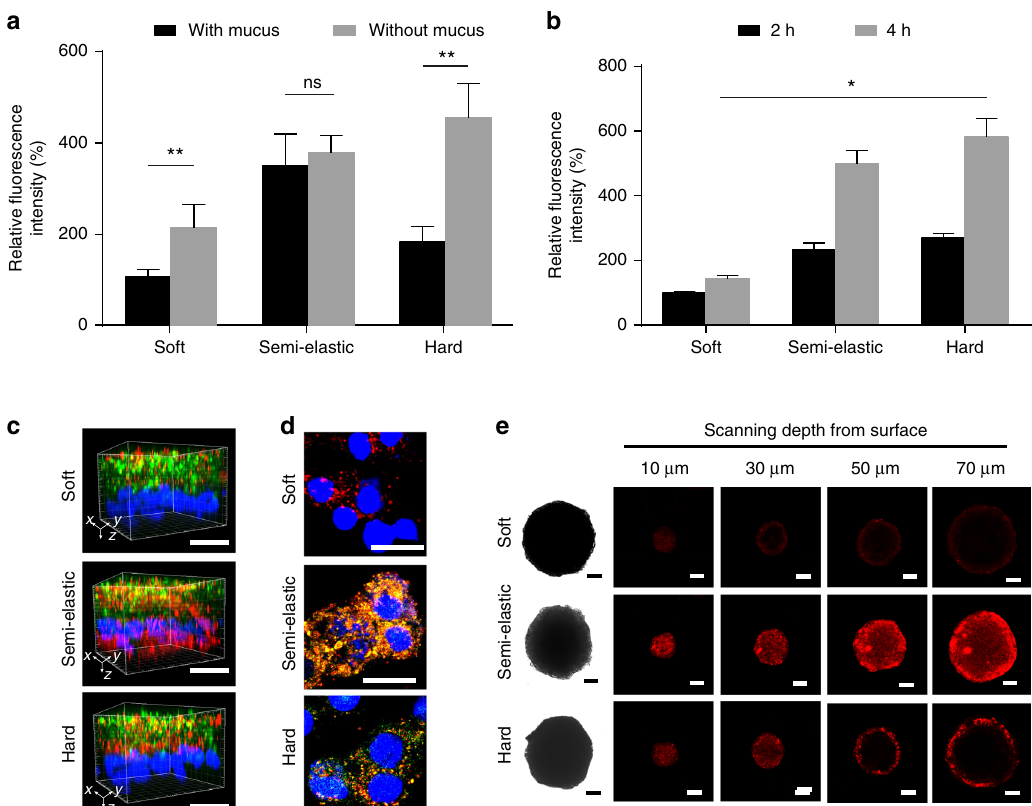
Fig. 3 Cellular penetration and uptake in vitro. a The internalization of NPs by E12 cells with or without pretreatment to remove mucus. Soft: Lip-F127 5% NPs; Semi-elastic: PLGA 70 -Lip-F127 5% NPs; Hard: PLGA 160 -Lip-F127 5% NPs. b Caco-2 cell-associated fl uorescence after different incubation times. c 3D images of the mucus penetration and cellular internalization of NPs in the E12 cell monolayer. Green: mucus stained with Alexa Fluor 488-wheat germ agglutinin. Blue: nuclei stained with Hoechst stain. Red: DiI-labeled NPs. Scale bar: 20 μ m. d Fluorescent confocal images of E12 cells (stained with 4 ’ ,6- diamidino-2-phenylindole [DAPI]) incubated with NPs for 2 h. Colocalization of the PLGA core entrapping DiO (green) and the lipid layer labeled by DiI (red) is indicated in yellow. Scale bar: 20 μ m. e NP penetration into the BxPC-3 and HPSC multicellular spheroids. Z-stack images were obtained starting from the top and into the core of the spheroid at intervals of 20 µ m. Scale bar: 50 μ m. Data are shown as the means ± standard deviations (SDs). ( n = 3) (ns, P > 0.05; * P < 0.05; ** P <